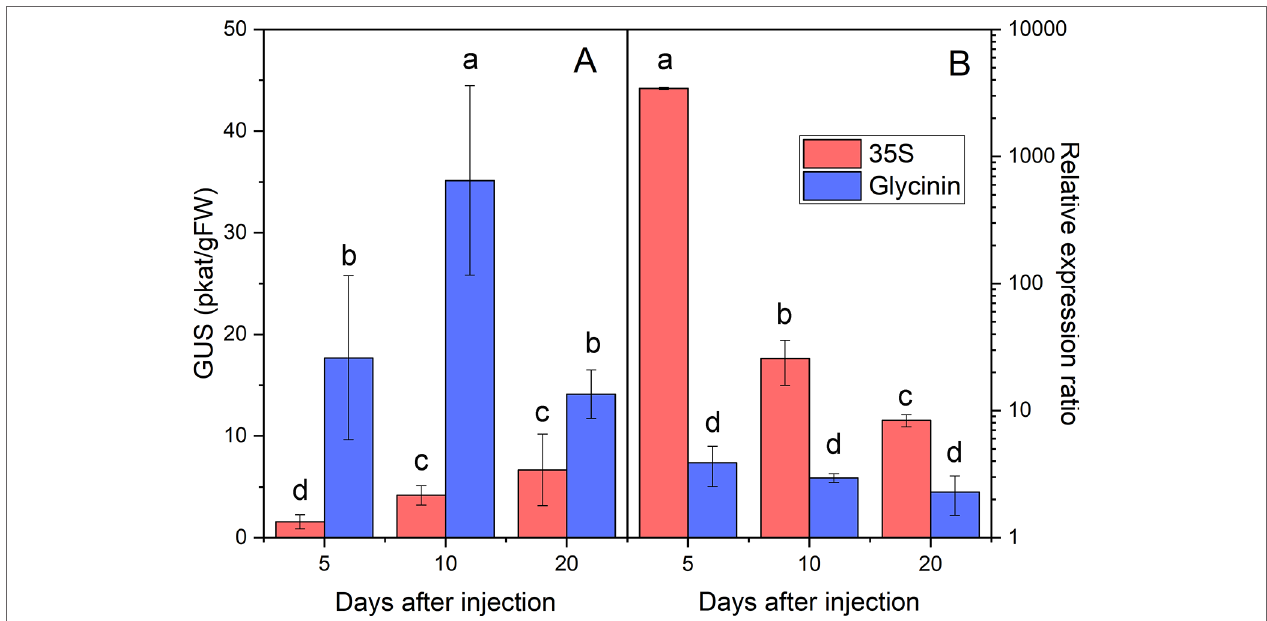
FIGURE 4 | GUS marker activity measured by fluorometry (A) and number of GUS transcripts measured by QRT-PCR (B) in transiently transformed developing castor bean seed endosperm. The data corresponds to the GUS marker driven by the CaMV 35S (red) and glycinin (blue) promoter. Data are the average ± SD of five endosperms harvested at 5, 10, and 20 days after injection (DAI). Letters, independents for each panel, indicate statistically significant differences (one-way ANOVA 0.05% significance level).